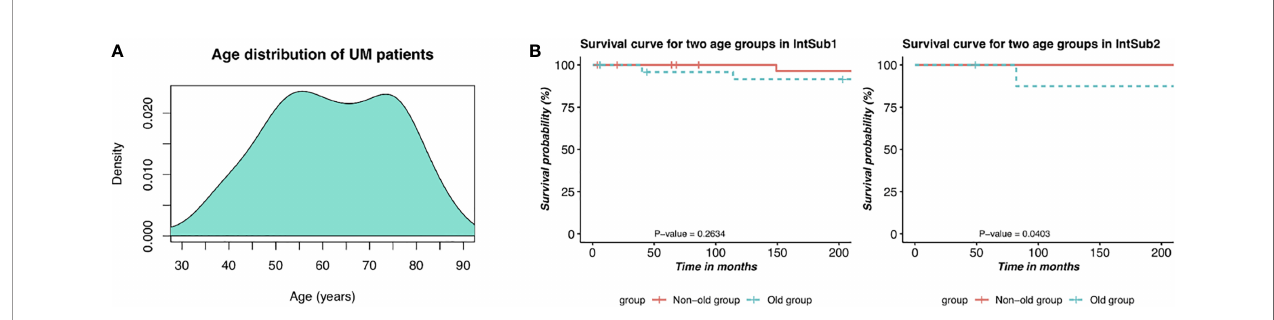
FIGURE 4 | Description of prognostic risks of UM patients in each integrative subtype. (A) Bimodal age distribution of UM patients. (B) Kaplan – Meier survival curves of patients in the two age groups in the two identi fi ed subgroups, IntSub1 and